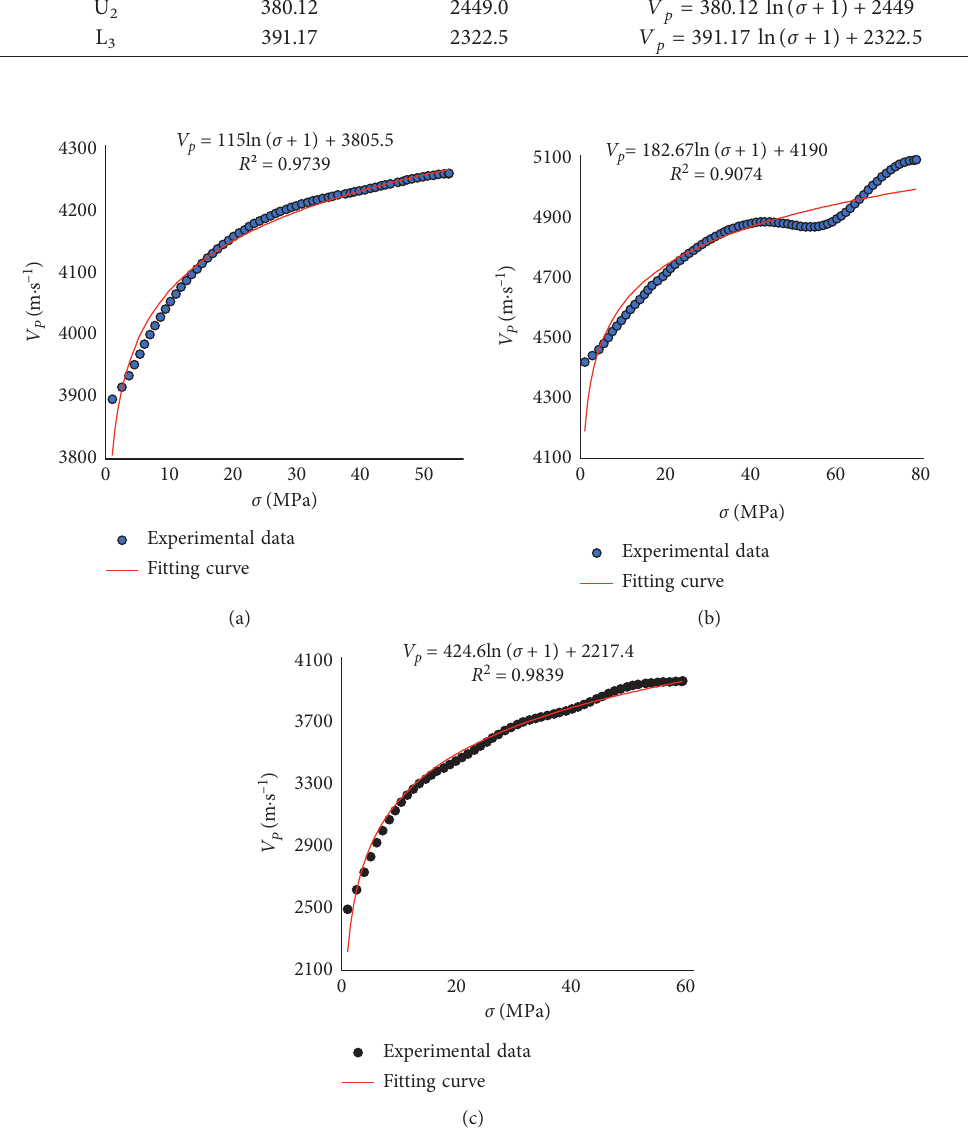
Figure 4: Relationship between the P-wave velocity and stress in the L1 stage of the sandstone specimens: (a) US1; (b) US2; (c) US3.